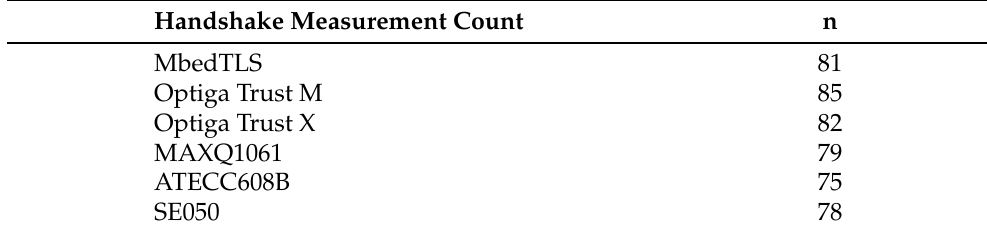
Table 6. Measurement count for the DTLS handshake after removing outliers caused by OpenThread.